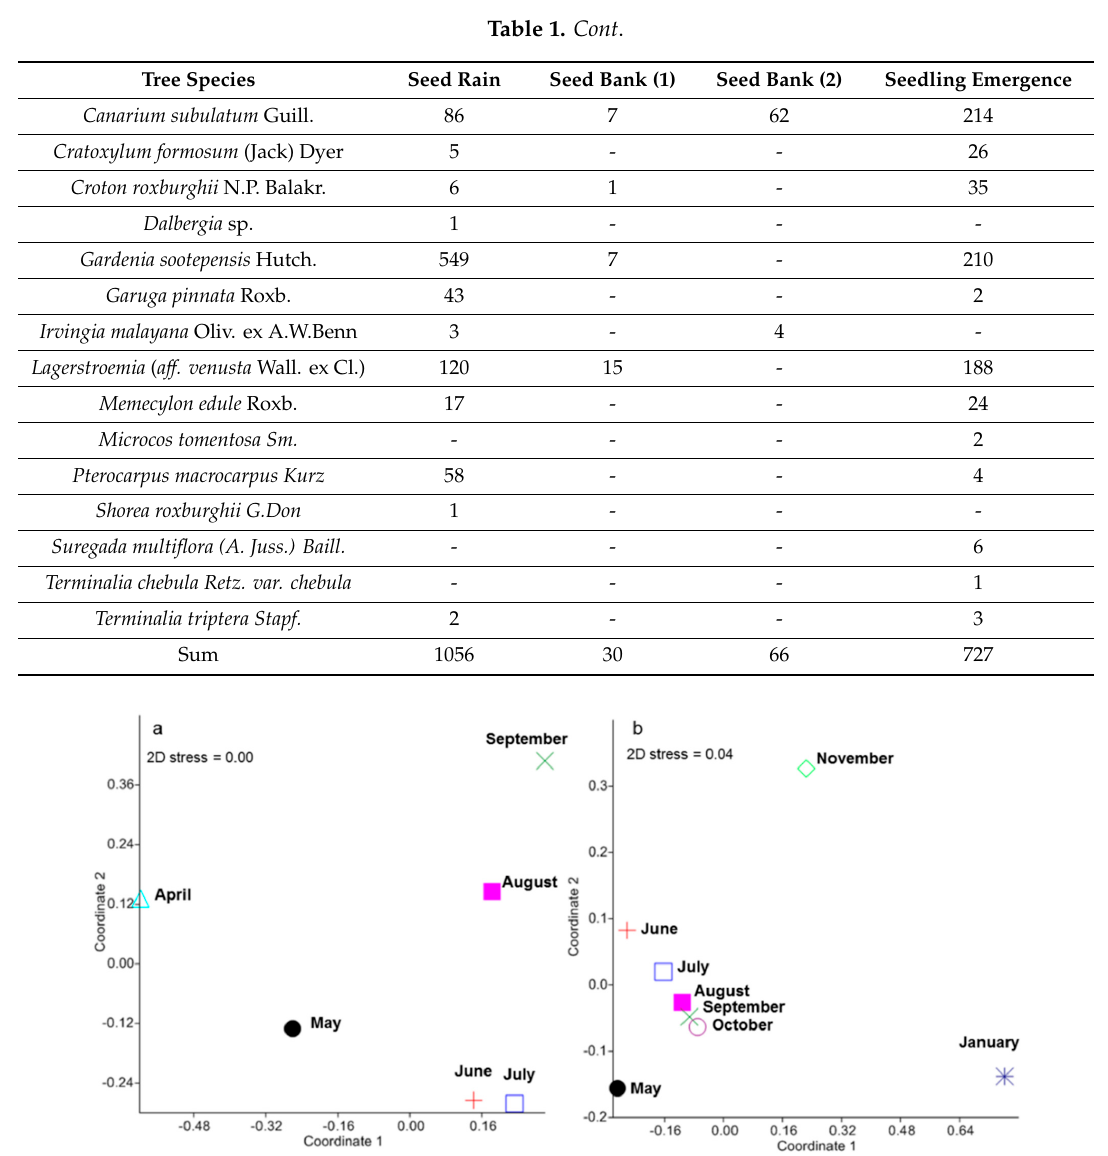
group (331 ± 51.97 geminated seed m − 2 ) and tree subgroup (48 ± 28.32 geminated seed m − 2 ). Asteraceae